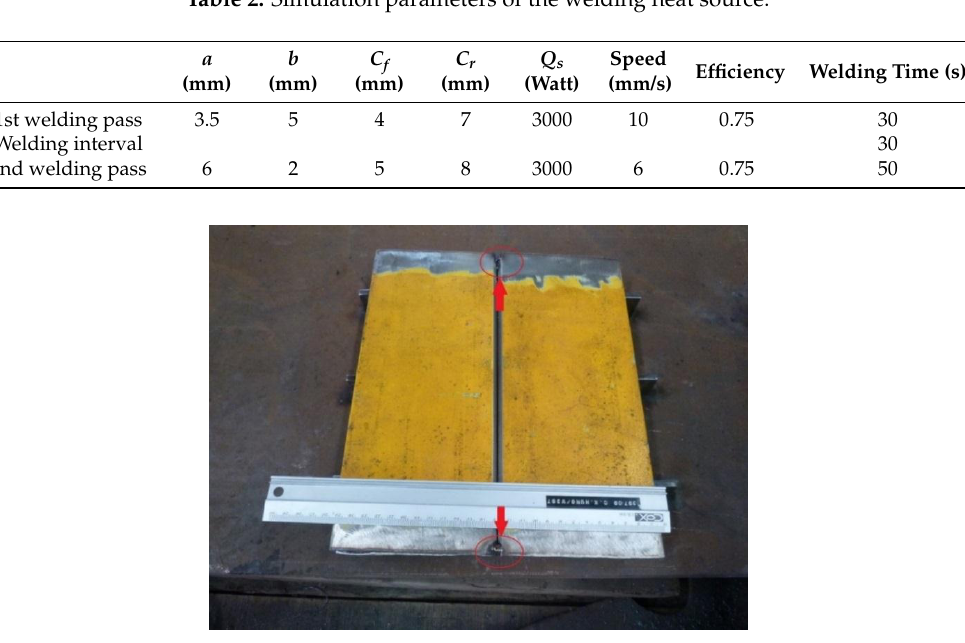
Table 1. Welding parameters for the test workpiece.